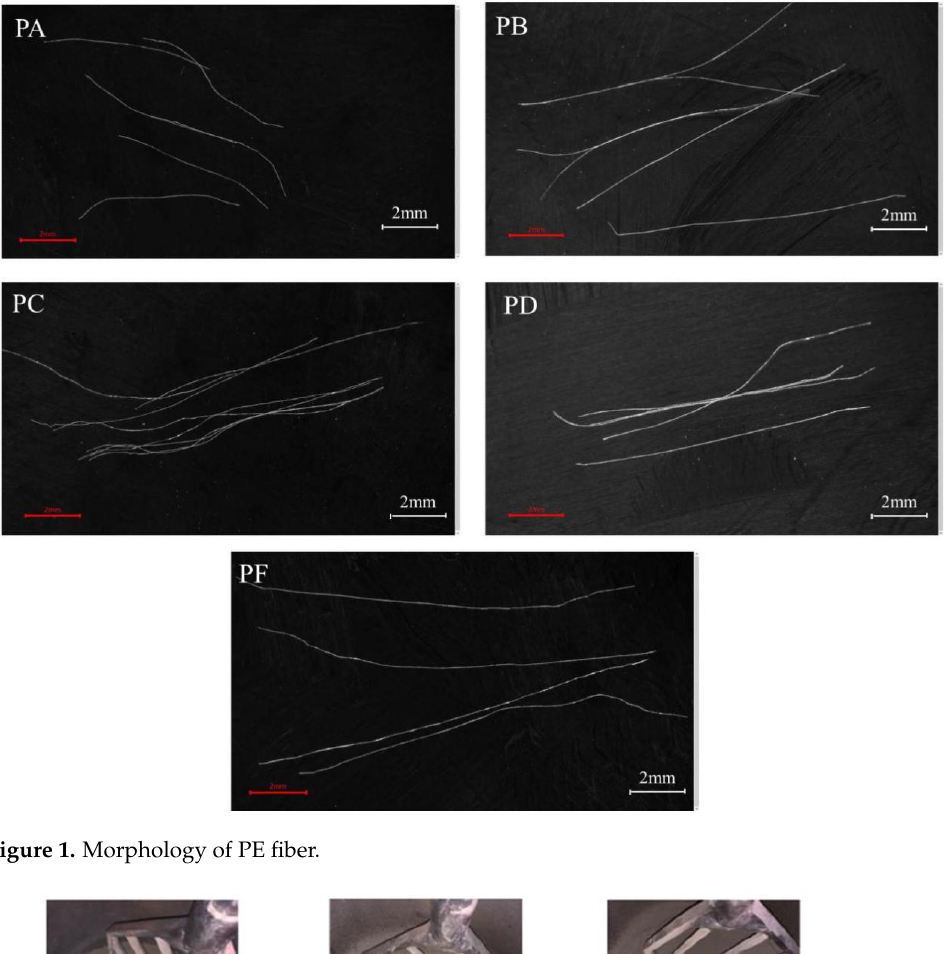
Figure 2. The values of the slump test regarding the workability of the fresh UHPC are listed in Table 3. It can be seen that, compared to the plain UHPC (its slump value is 265 mm), the slump values decline gradually with the addition of PE fiber. The slump values of all mixtures are larger than 130 mm.